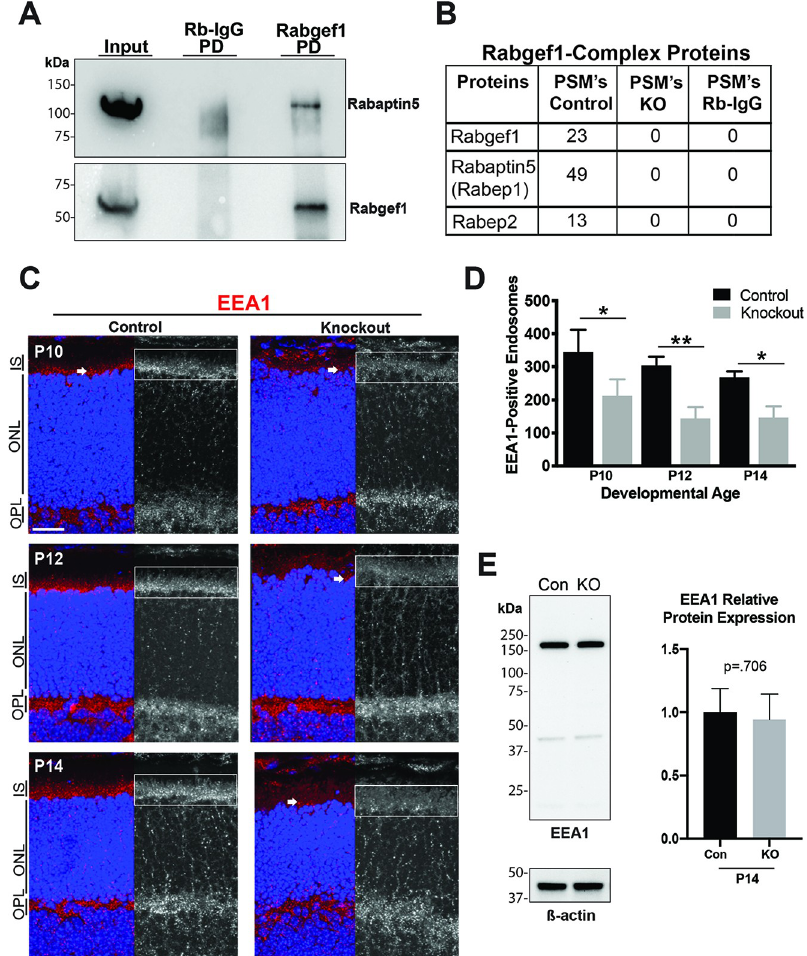
Fig 5. Conserved endocytic function of RabGEF1 in the retina. (A) Immunoblot analyses of Rabbit-IgG and anti- RabGEF1 pulldown (PD) protein complexes (from 40 μ g retinal lysate) with antibodies against RabGEF1 and Rabaptin5. Input was 3% of the protein from the control P21 mouse retinal lysate. Rabbit-IgG served as a negative control. (B) Mass spectrometry analysis of RabGEF1 co-immunoprecipitated proteins from P21 control and Rabgef1 -/- retinas. RabGEF1 binds to Rabaptin-5 in a 1:2 ratio respectively (n = 2). (C) Immunohistochemistry with anti-EEA1 antibody on control and Rabgef1 -/- retinal slices. Retinal sections were counterstained with DAPI. IS, inner segment; ONL, outer nuclear layer; OPL, outer plexiform layer. Scale bar = 20 μ m. Boxed areas indicate regions of retina that were quantified, also shown at larger scale in S5B Fig. (D) Quantitative measurements of EEA1-positive endosomes at P10, 12 and 14 control and Rabgef1 -/- individual z-stack images of the inner segment regions. ( E) Immunoblot of control and Rabgef1 -/- P14 retinal lysates probed with anti-EEA1. Anti-beta-actin was used as a loading control. There is no significant difference between EEA1 protein amounts in control and Rabgef1 -/- retinal lysates Asterisks indicate p-value < 0.05 ( � ) and < 0.01 ( �� ) as determined by t-test using Prizm software. In panels D and E, n = 3 biological replicates. Error bars indicate